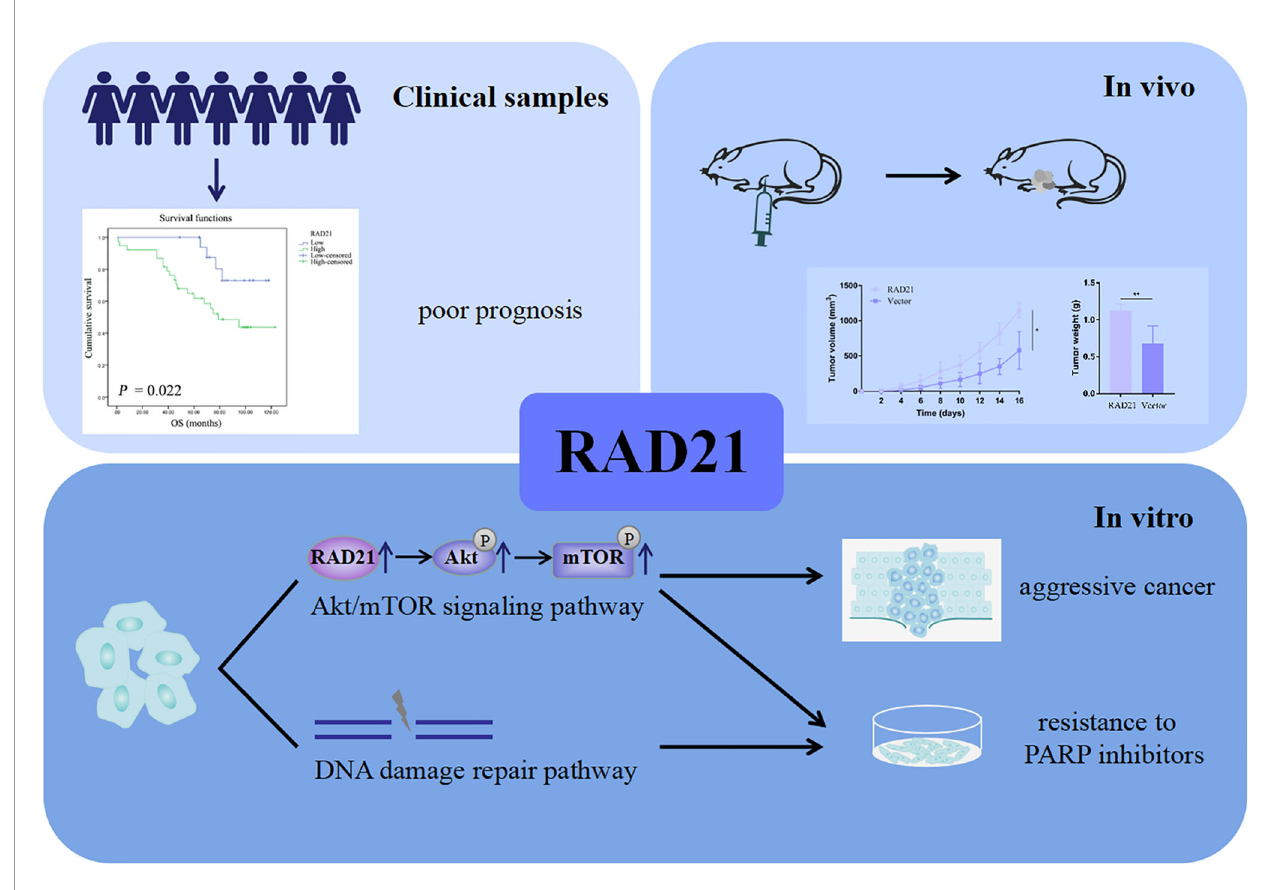
FIGURE 7 | A schematic diagram illustrating the role of RAD21 in ovarian